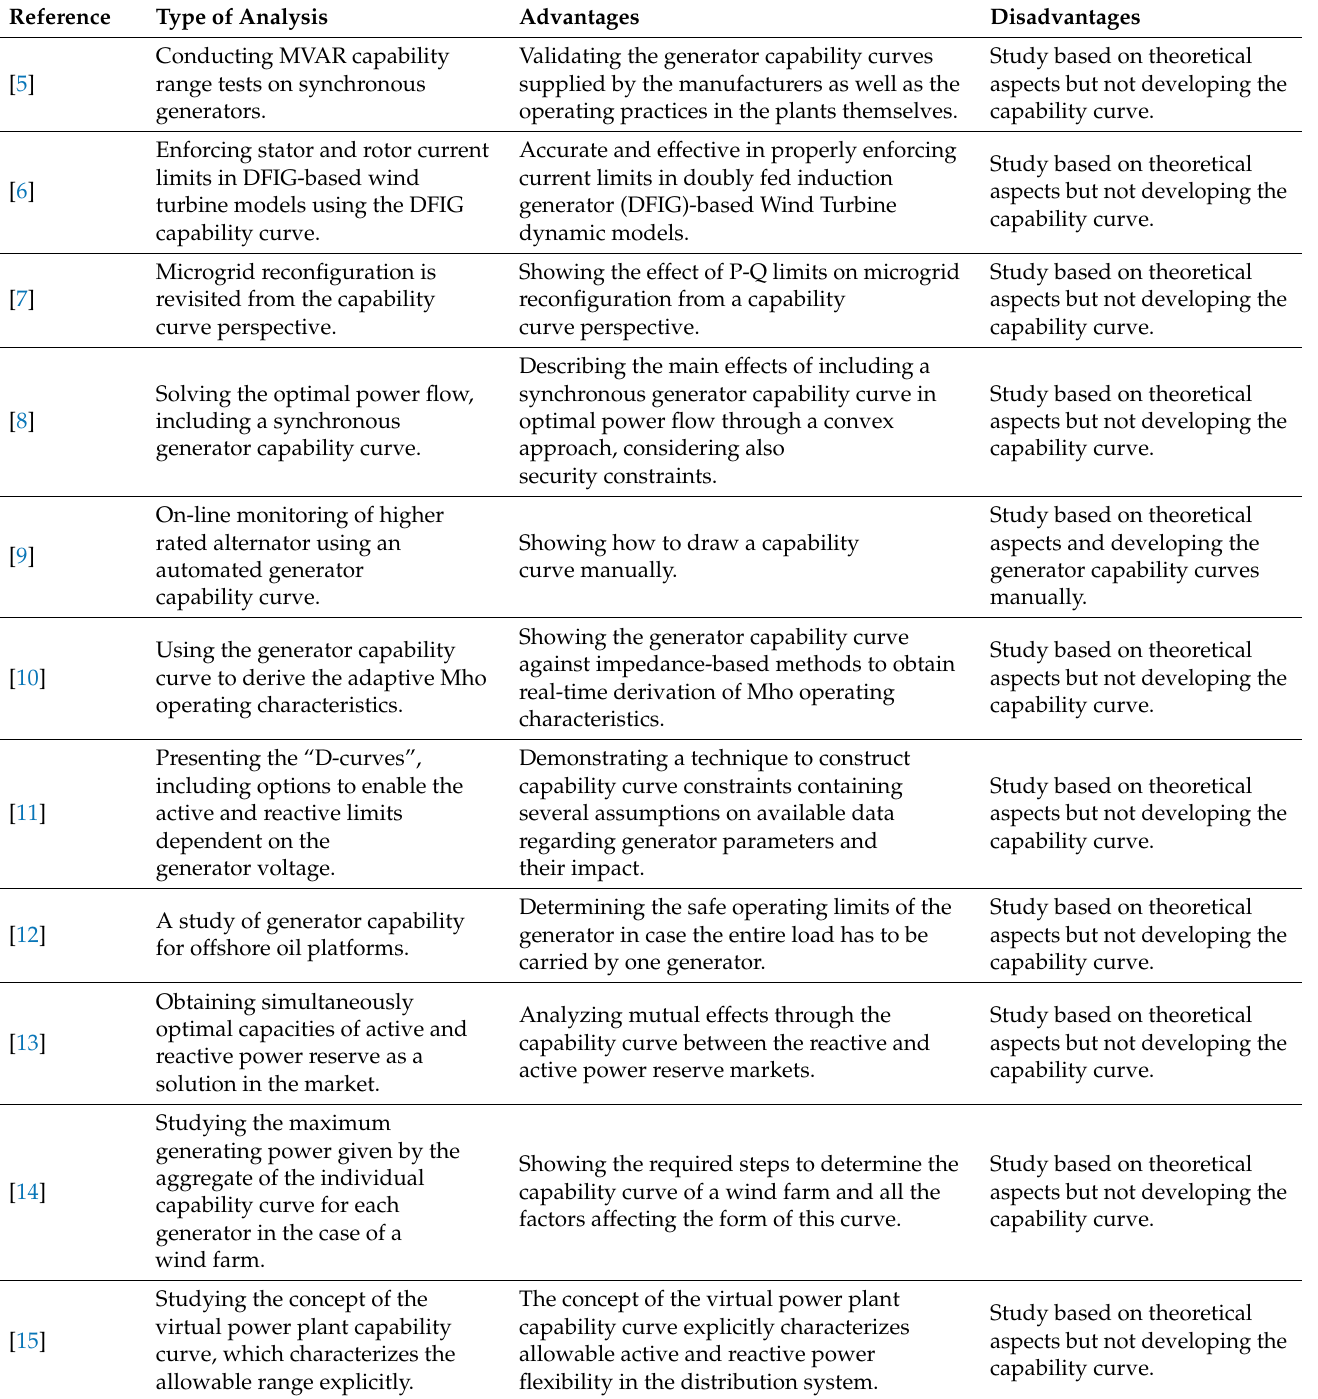
Table 1. Solutions proposed in the literature depending on the type of analysis, the advantages, and the